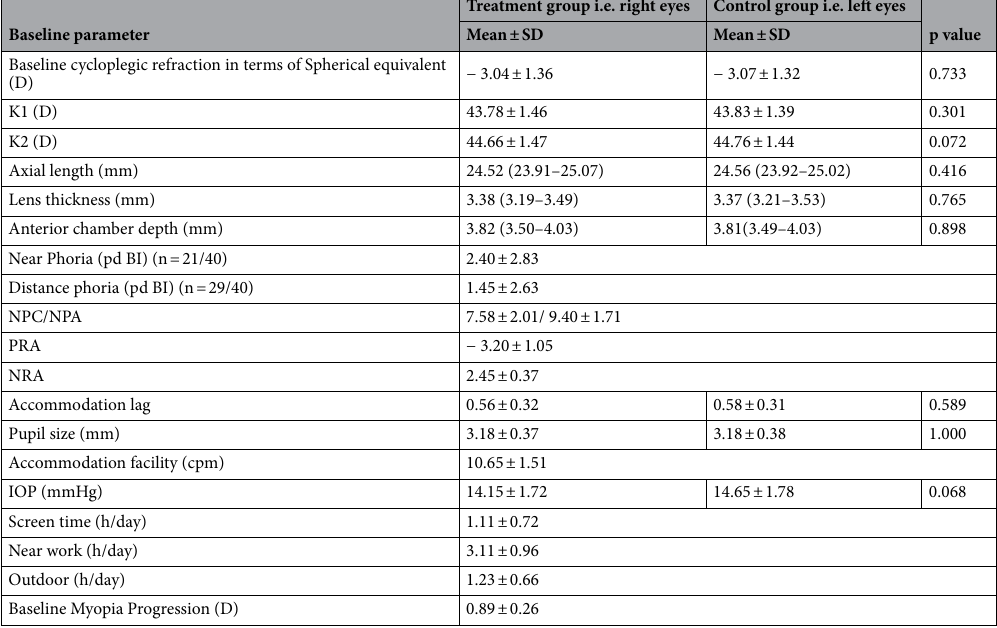
Table 1. Average of baseline parameters in treatment and control eyes (before the start of study). D dioptre, K keratometric reading, PBCT prism bar cover test, pd prism dioptre, BI base in, NPC near point of convergence, NPA near point of Accomodation, NRA Negative relative accommodation, PRA positive relative accommodation, cpm cycles per minute, IOP intra-ocular